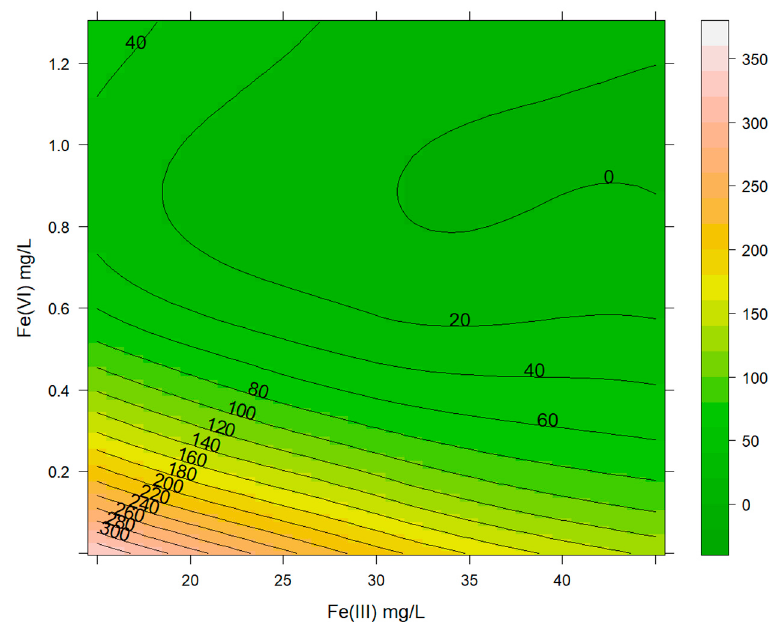
Figure 3. Local polynomial regression-fitting adjustment to assess the effects of Fe(III) and Fe(VI) on the final arsenic concentrations at the initial concentration of 500 µg L − 1 of As(III) and 500 µg L − 1 of As(V).